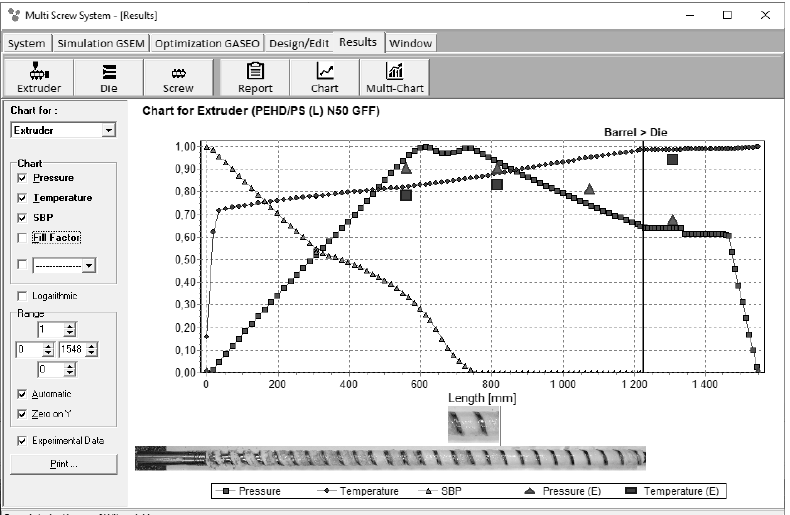
Figure 3. Overall extrusion process characteristics, simulation and experimentation data using the GSEM model—flood fed single screw extrusion: SBP—solid bed profile, E—experiment [68].